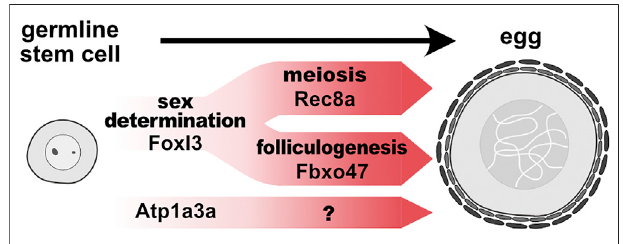
FIGURE1| Geneticallydistinctpathwayspromotegermlinefeminization in medaka. In germline stem cells, foxl3 , an intrinsic factor of germ cell sex, directly activates expression of rec8a and fbxo47 to initiate meiosis and folliculogenesis, respectively. Other female-speci fi c pathways (e.g., atp1a3a ) may also promote another module independently of foxl3